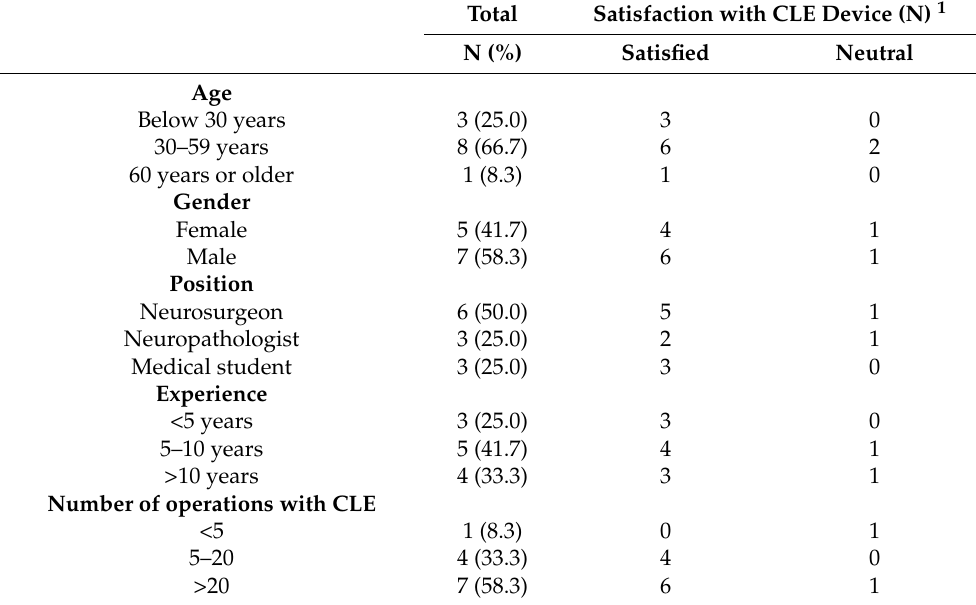
Table 3. Characteristics of the survey